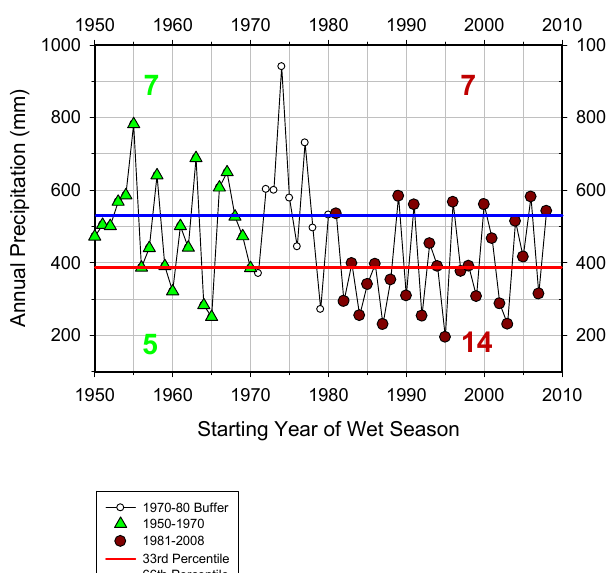
Figure 5. Results from the hypergeometric test of the total annual precipitation amounts, based on their water (May–April) for the year from the periods 1950–1970 and